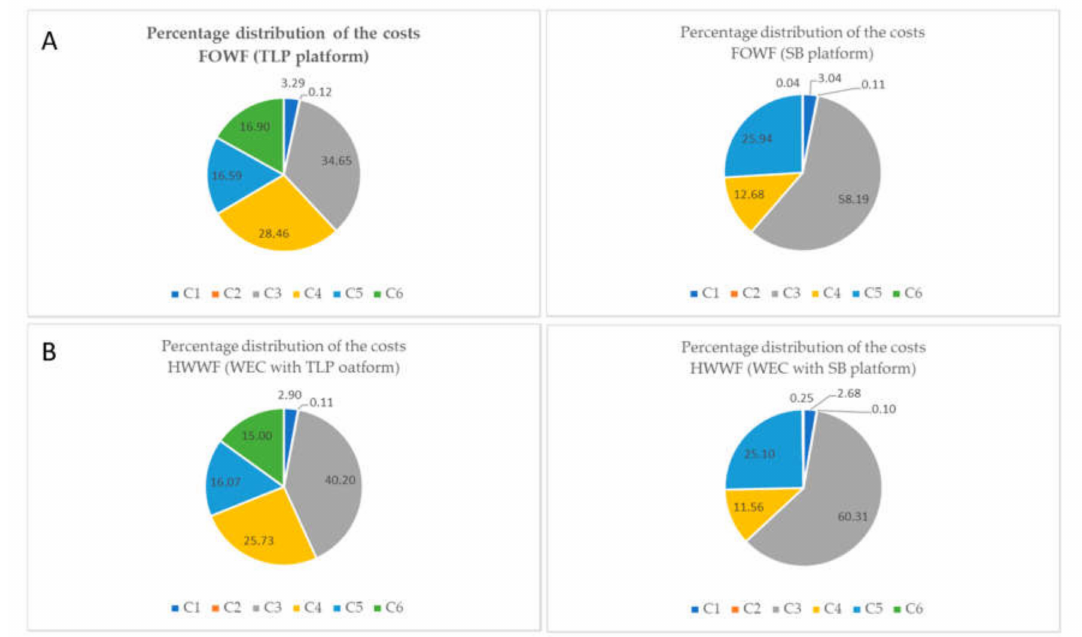
Figure 6. Percentage distribution of the costs for the two FOWFs ( A ) and for for the two HWWFs ( B